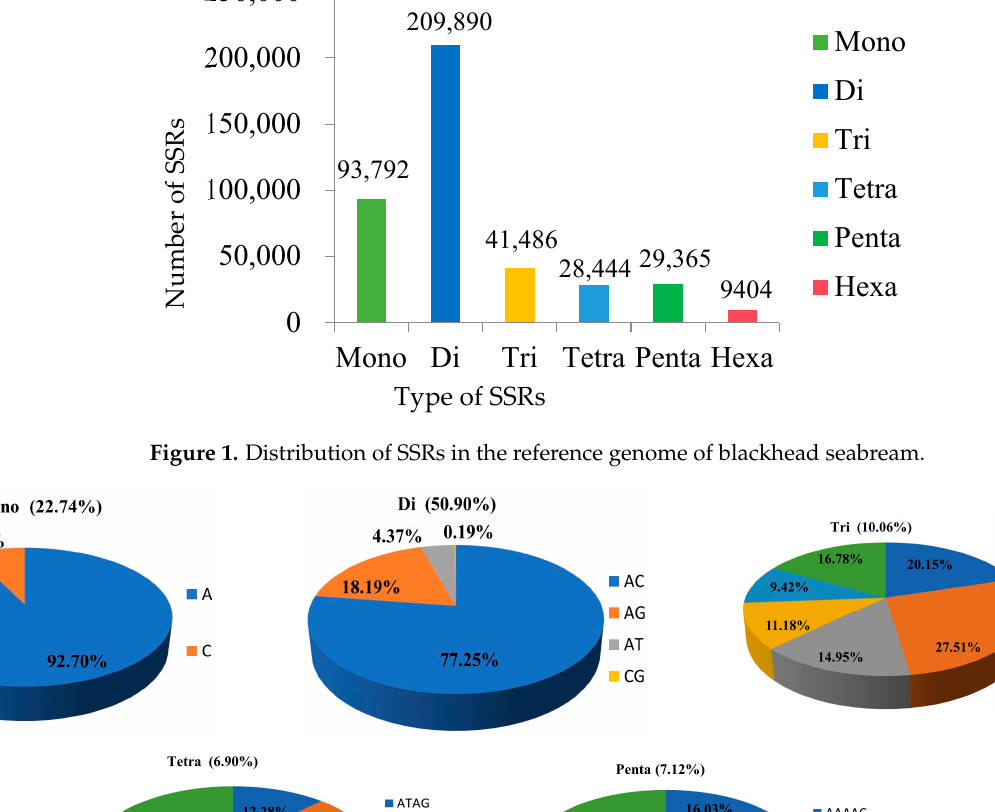
Figure 1. Distribution of SSRs in the reference genome of blackhead seabream.